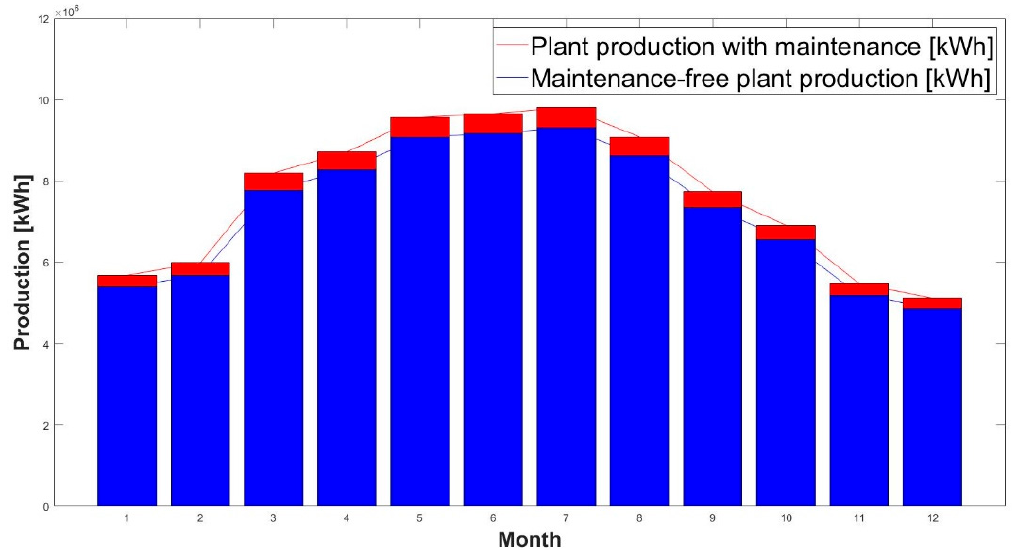
Figure 21. Variation in production at the 50 MWp plant.